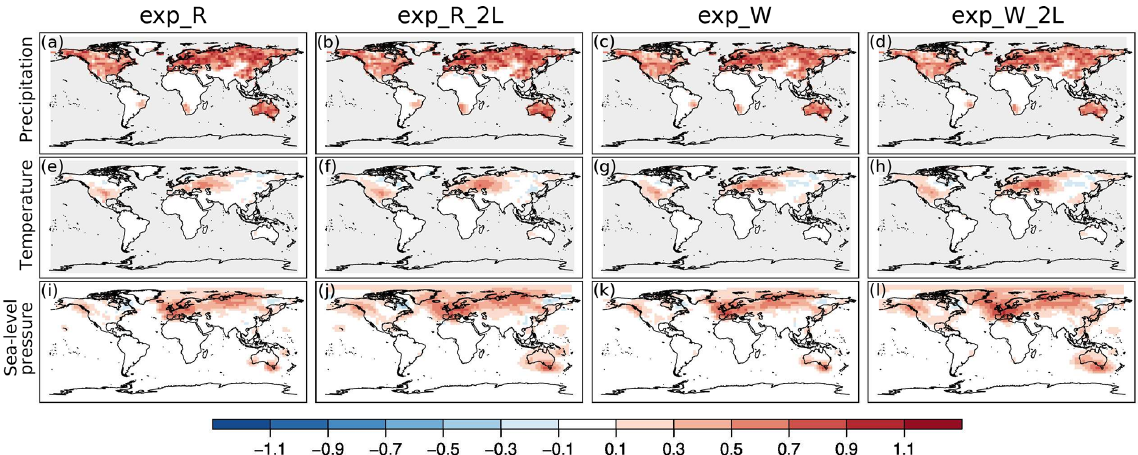
Figure 3. Summer season correlation differences of precipitation (a, b, c, d) , temperature (e, f, g, h) , and sea-level pressure (i, j k, l) between the analyses and the CCC400 model simulation ensemble means by assimilating only precipitation amounts (a, e, i) , only precipitation amounts with a doubled localization length scale parameter (b, f, j) , only the number of wet days (c, g, k) , and only the number of wet days with a doubled localization length scale parameter (d, h, l) .